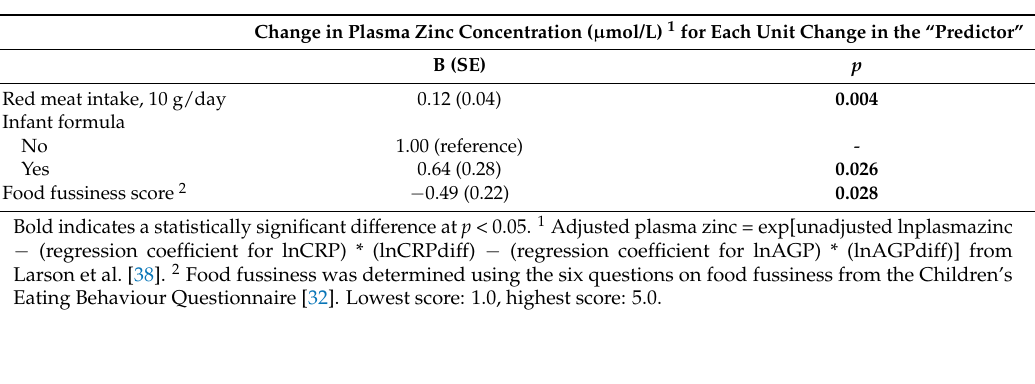
Table 5. Multiple regression analysis of “predictors” of plasma zinc concentrations at 12 months of age ( n =